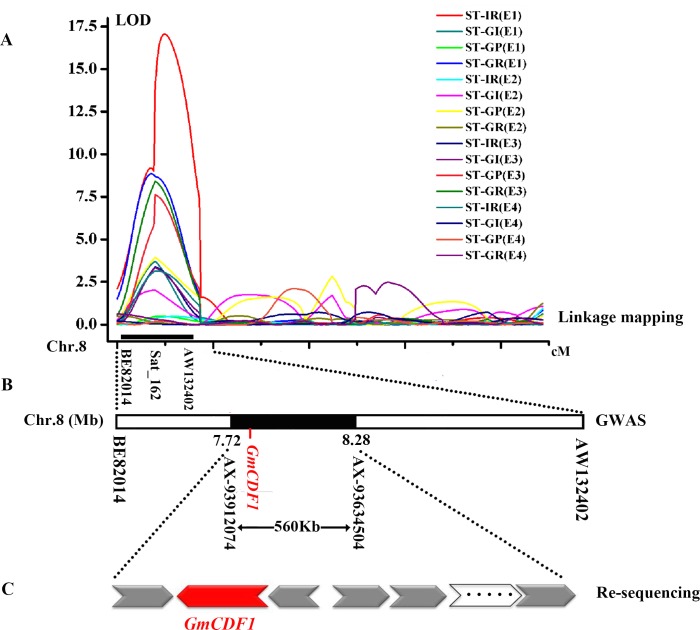
Identification of GmCDF1 through an analysis combining linkage mapping, GWAS and resequencing.(A)
qST-8 (QTL related to salt tolerance on chromosome 8) was identified in the samples of 184 recombinant inbred lines (RILs) collected from all four years and mapped to the interval between the markers BE82014 and AW132402 by linkage mapping. (B) This QTL was further narrowed down to a physical region of 560 kb between the SNPs AX-94047897 and AX-93634504 on chromosome 8 by GWAS. (C) Resequencing was performed to detect the different genes located within the region identified in (B) between the two parents of the RILs population, Kefeng No. 1 and Nannong 1138–2.